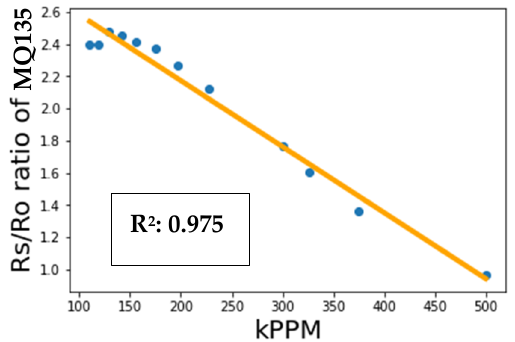
Figure 9. Calibration curve for MQ135 sensor integrated in a device.